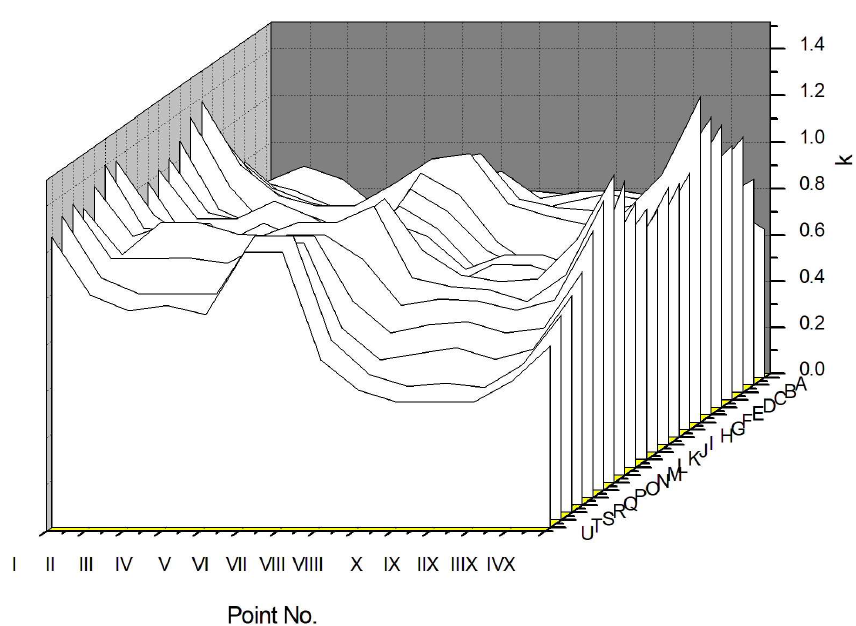
Figure 11. Profile of k in the dark field for blue thin-film.